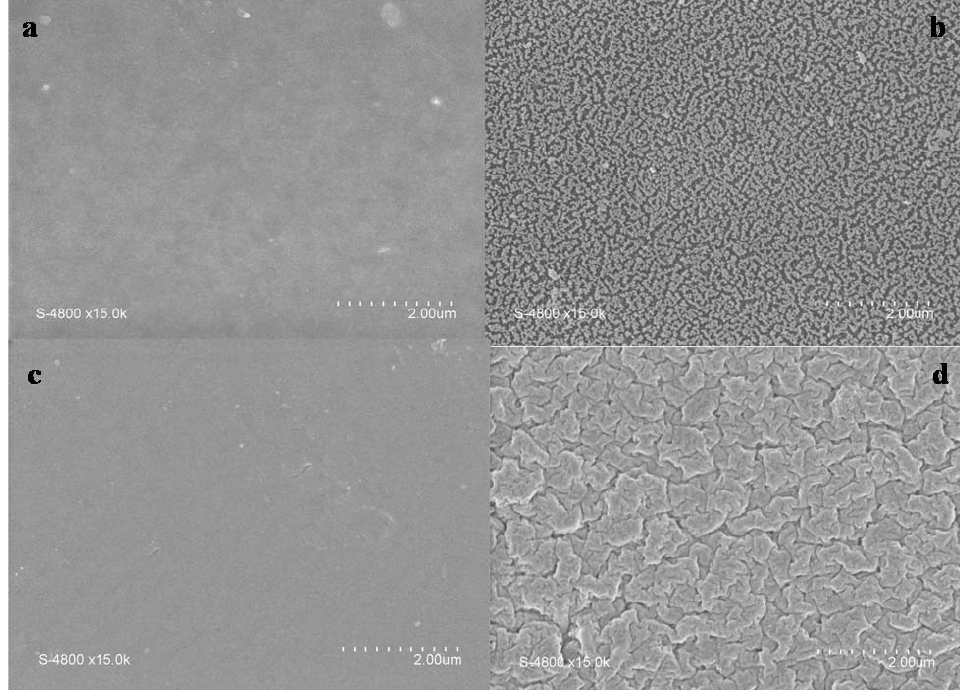
Figure 1. Scanning electron microscopy (SEM) pictures of representative faces of